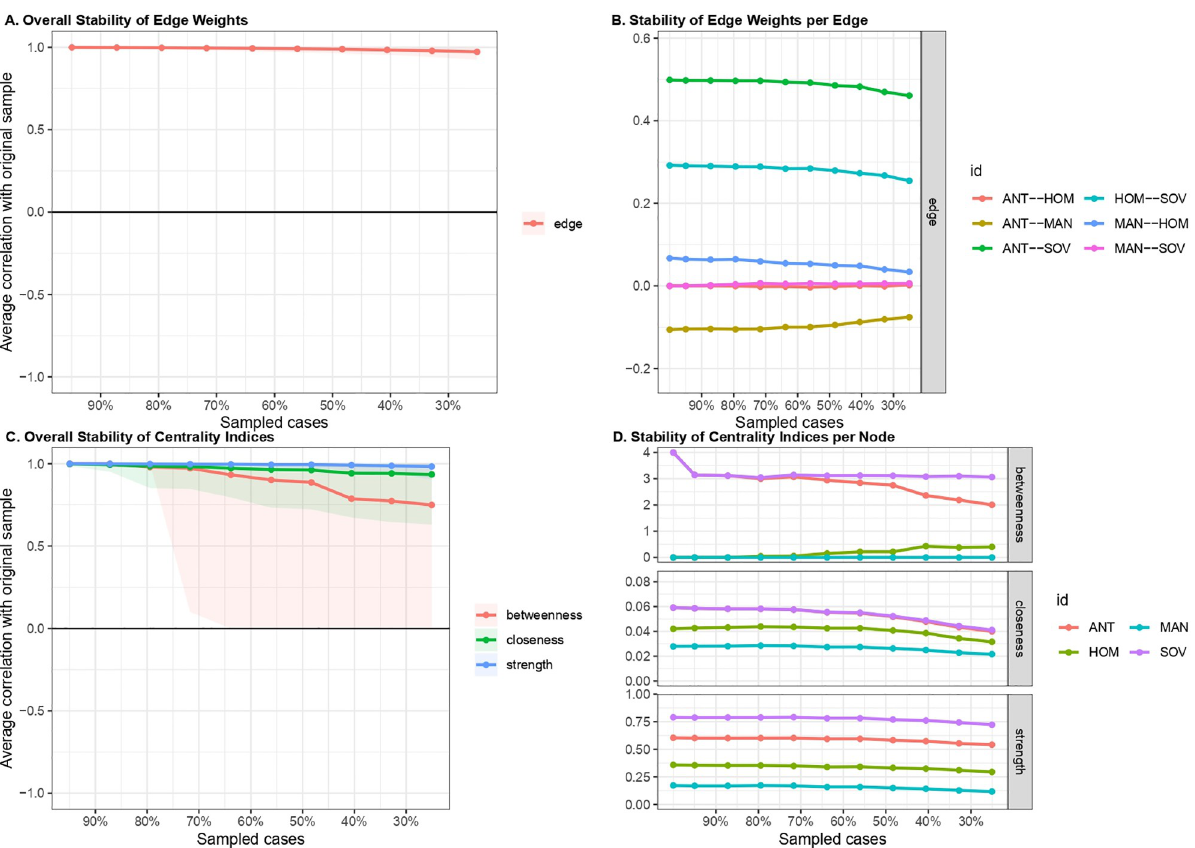
Fig 6. Stability of edge weights and centrality indices of populist ideology dimensions network. (A) Overall stability of edge weights. (B) Stability of each edge weight. (C) Overall stability of estimated centrality indices. (D) Stability of estimated centrality indices for each node. left-wing party: M = 0.68, se = .13, p < .001, 95%CI = 0.261, 1.095). The average for M5S vot- diff ers overlapped with abstainers’ average score ( M = -0.24, se = .15, p = .99, 95%CI = -0.713, diff